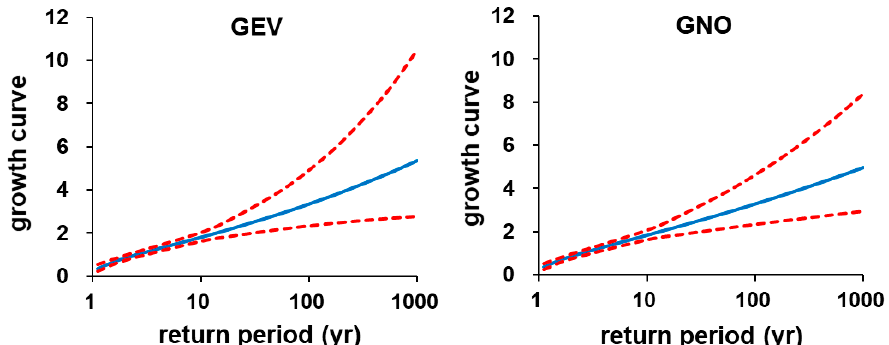
Figure 4. Regional growth curves with 90% error bounds. GEV distribution (left); GNO distribution (right).